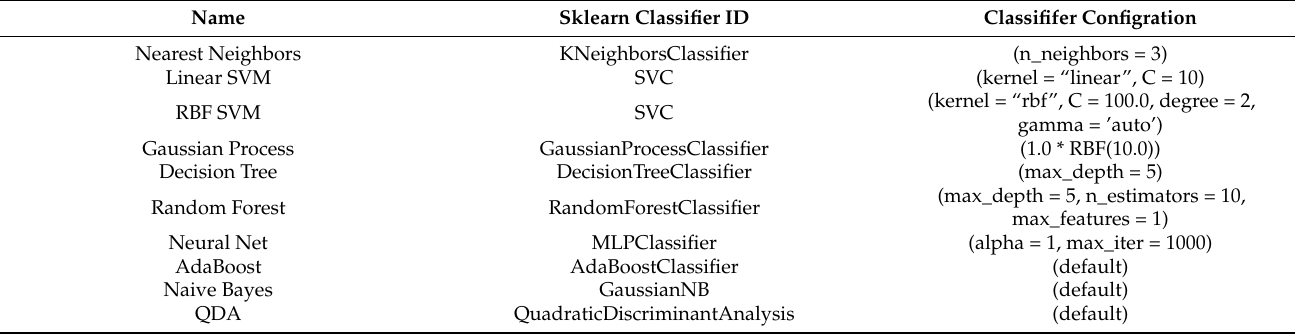
Table 2. Sklearn classifiers configuration